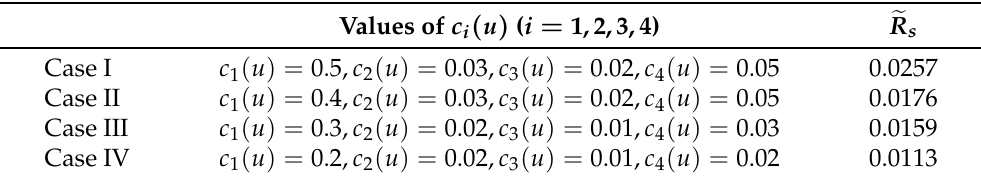
Figure 3. Total variation norms (cid:107) P ( t , ( χ ( t ) , n ) , · ) − π ( · ) (cid:107) are plotted due to variations of c i ( u ) ( i = 1, 2, 3, 4) under four different cases corresponding to Table 1. √ Table 1. When σ i 1 ( n ) = 0.04 + 0.01sin n , σ i 2 ( n ) = 0.1 + 0.05sin n ( i = 1,2,3,4 ) , values of (cid:101) R s are given under four different values of c i ( i =